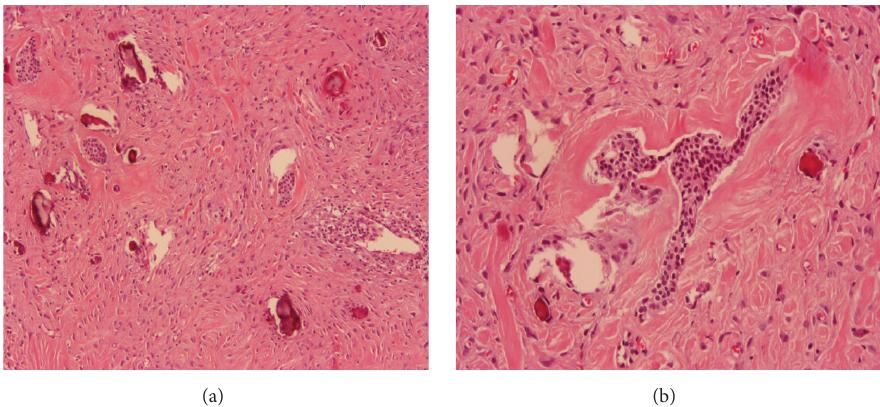
Figure 3: (a) Microscopic view of the lesion demonstrating the presence of fibroblastic and collagenous tissue with many strands of odontogenic epithelial cells and focally calcified foci resembling osteoid and cementoid material (H&E stain × 100 magnification). (b) Odontogenic epithelial nests without cytological atypia in a fibroblastic and collagenous stroma with hyaline areas (H&E stain × 200 magnification).